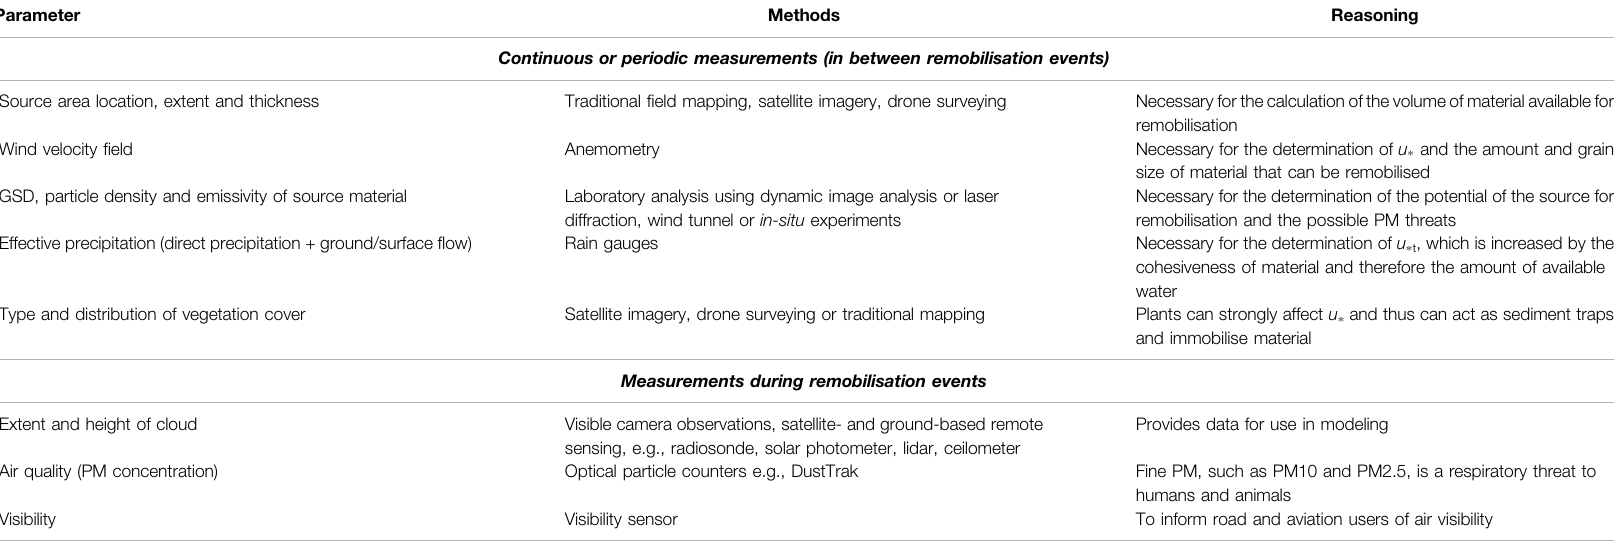
TABLE 2 | Parameters to be monitored during and in between remobilisation